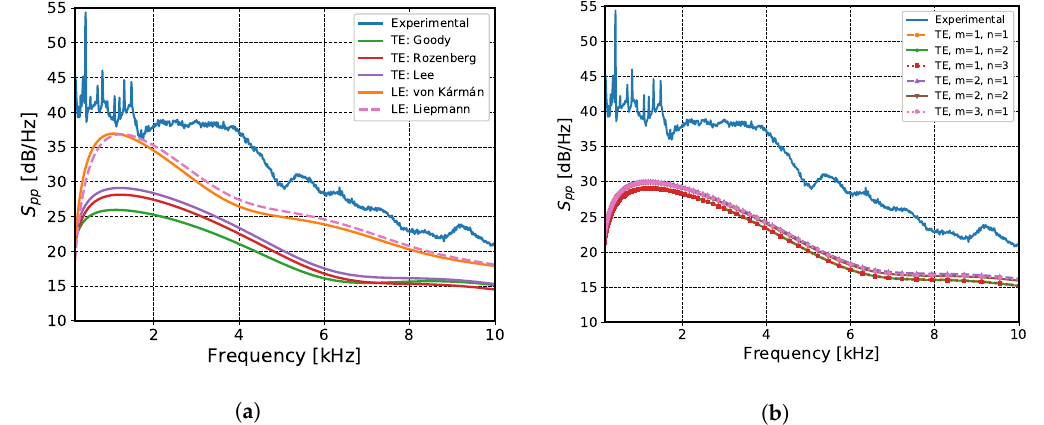
Figure 13. A parametric study is proposed for the SW case by comparing the predicted results with the measured ones: in ( a ), 3 semiempirical wall-pressure models Lee’s, Rozenberg’s, and Goody’s are compared for the TE case; 2 turbulence velocity fluctuations models: von Kármán’s and Liepmann’s are compared for the LE case. In ( b ), several combinations of the Corcos’ order coefficients m and n are tested